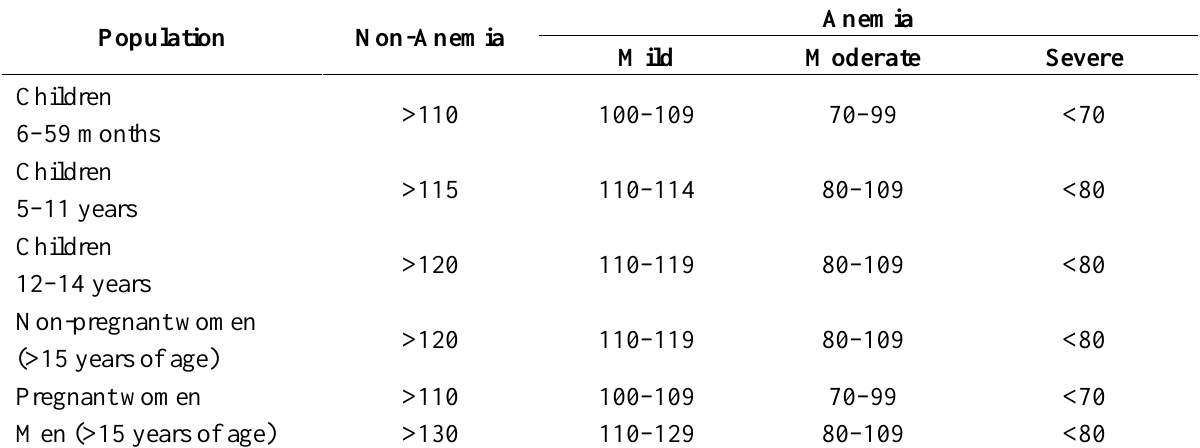
Figure 1. Biochemical markers of iron status [10]. Table 1. Hemoglobin cut-off levels (g/L) to diagnose